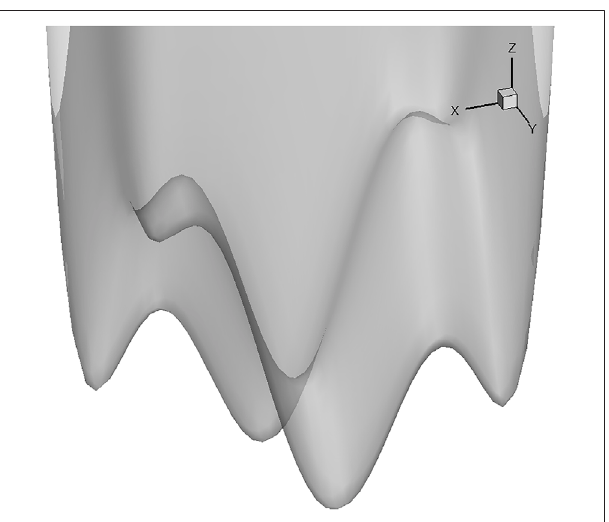
FIGURE 6 | Six-peak humpback